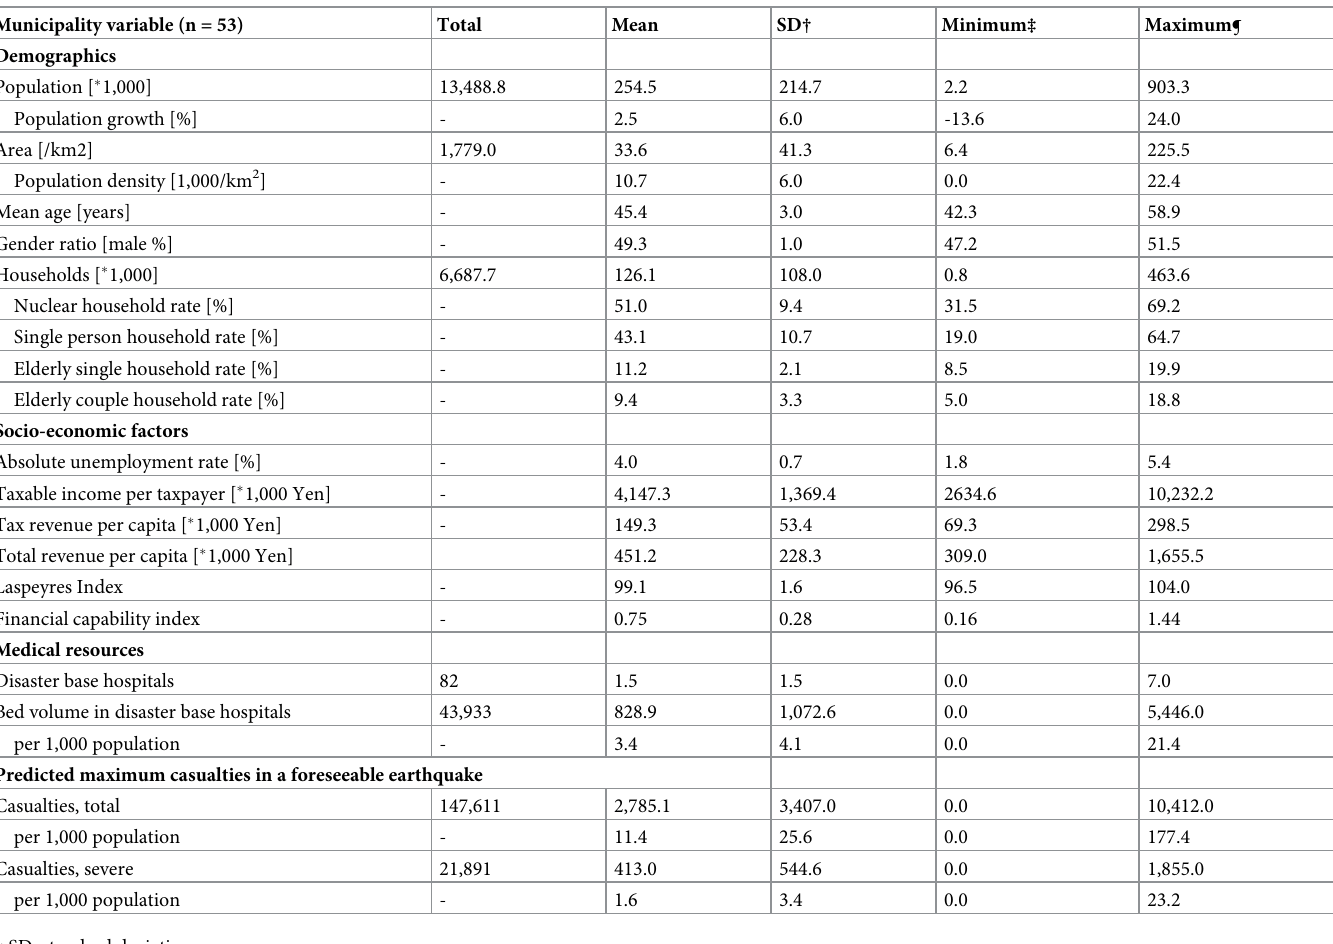
Table 1. Municipality-level distributions of demographics, socio-economic factors, medical resources, and predicted maximum casualties in a future